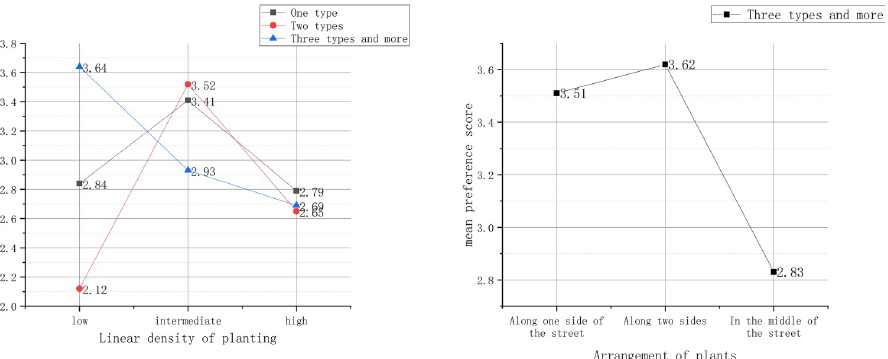
Fig 4. Linear density of planting and arrangement of